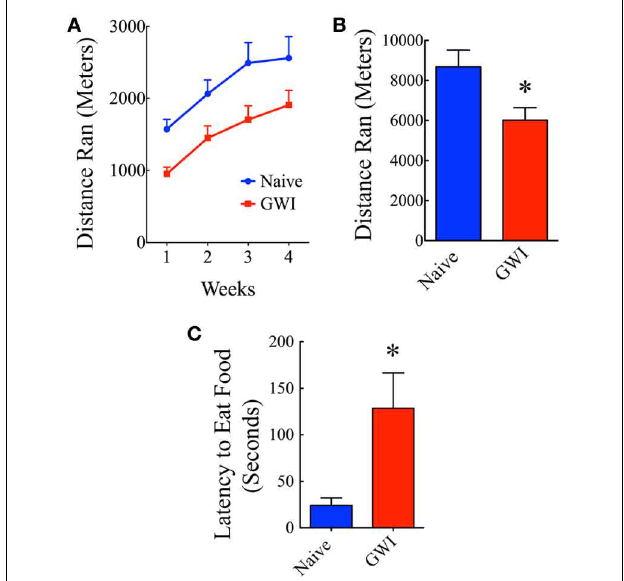
FIGURE 5 | Exposure to Gulf War illness related (GWIR) chemicals and stress causes alterations in motivation levels and depression. (A) Compares distances ran by rats in the naive group and the GWI group over 4 weeks following housing in cages fitted with running wheels. Repeated measures Two-Way ANOVA revealed that animals in the GWI group displayed an overall reduced motivation for running than the naive control group ( p < 0 . 05, F = 6.5). Bonferroni post-tests revealed that differences were significant in the 3rd week of running between the two groups ( p < 0 . 05). However, both groups exhibited an increased motivation for running over the course of 4 weeks ( p < 0 . 0001, F = 33 . 5). (B) Compares cumulative distances ran by the two groups in 4 weeks. (C) Compares latencies to eat food between the two groups in a novelty suppressed feeding test performed after 24h of fasting. Note that latencies to eat food following fasting are greater in GWI-rats, implying depression in these animals. ∗ p < 0 . 05 (two tailed, unpaired Student’s t